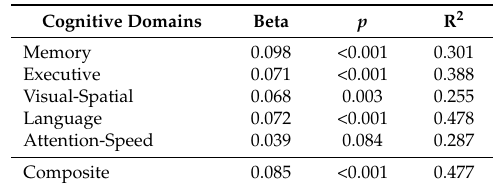
Table 2. Results from linear regression analyses that evaluated the association between Total Lifestyle Index (TLI) (independent variable) and cognitive domains (dependent variables) in non-demented participants.